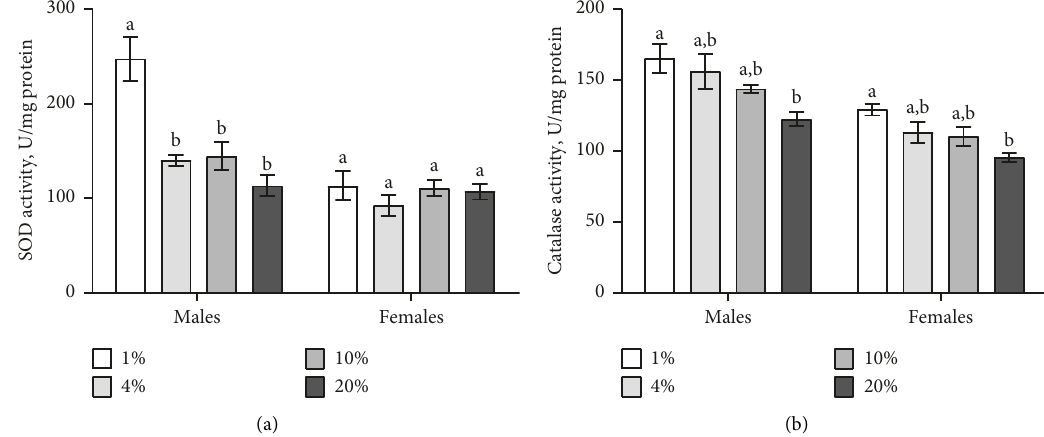
Figure 3: Activities of SOD and catalase in flies that consumed diets with different sucrose concentrations. Results are shown as mean ± SEM, n � 4. Values were compared using Tukey’s test: a indicates the highest mean among all tested groups; b indicates a significant difference from a, with p < 0 . 05.